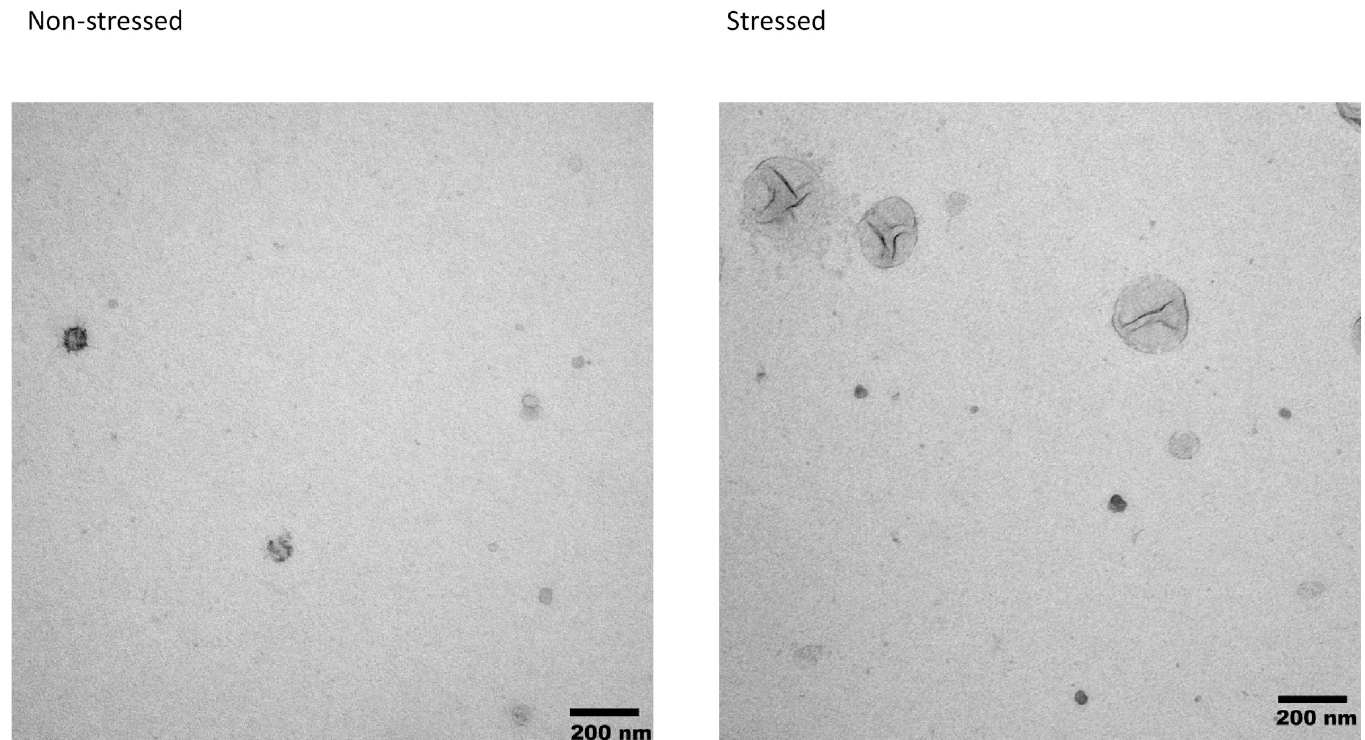
Fig 6. Electron microscopy images of extracellular vesicles under stressed and non-stressed conditions.